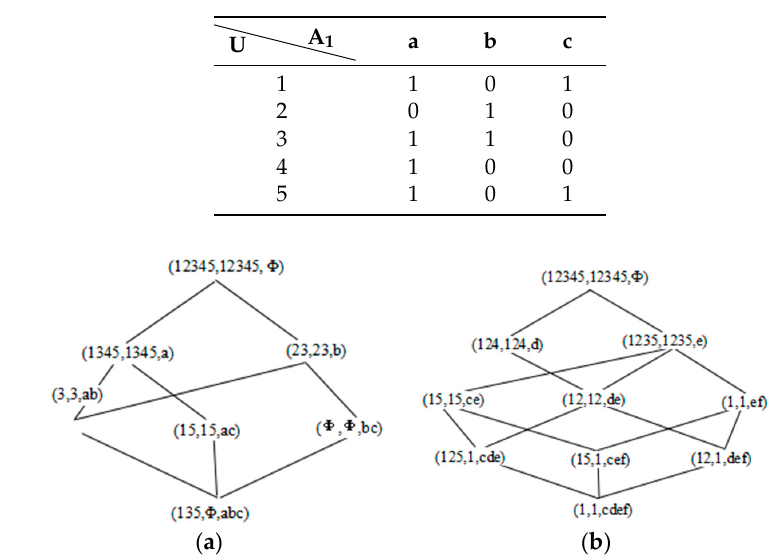
RAUL β L . Figure 1. ( a ) The lattice structure L β of 2 β β ( U , A ) of L β α α 22 2 , R 2 α α